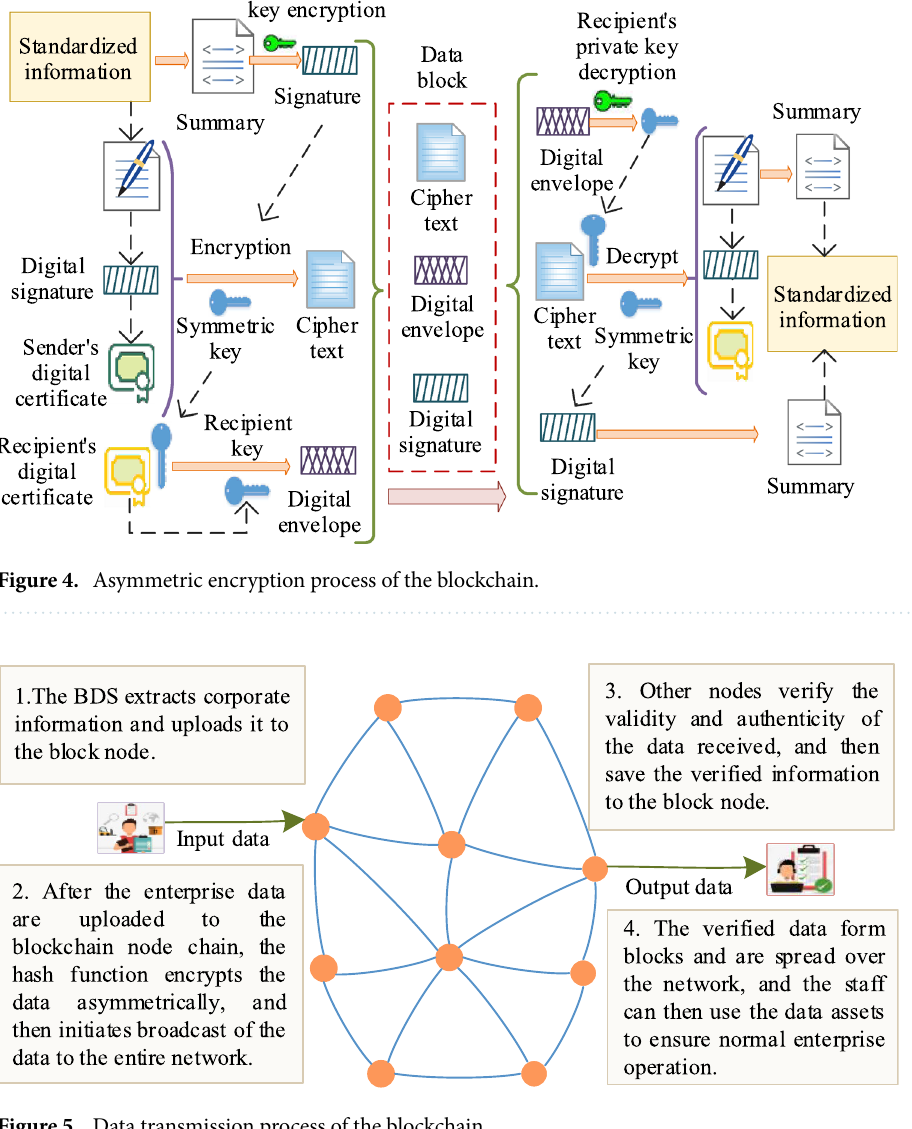
Figure 5. Data transmission process of the